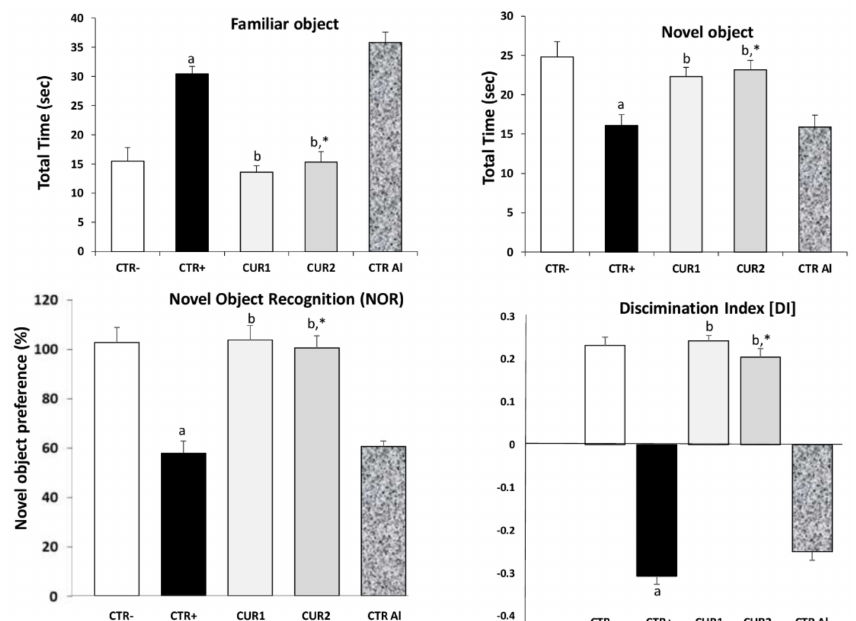
Figure 1. Effect of co and post-treatment of curcumin on cognitive impairment on rat model of Alzheimer’s Disease (AD) induced by chronic administration of AlCl 3 . Values are mean ± SEM. Note: CTR − : negative control group; CTR+: positive control group (treated by aluminum chloride (AlCl 3 )); CUR1: co-treatment with curcumin; CUR2: post-treatment with curcumin; CTRAl: exposed to AlCl 3 for 90 days and survive 60 days without any treatment; a: p < 0.05 as compared to CTR − group; b: p < 0.05 as compared to CTR+ group; *: p < 0.05 as compared to CTRAl group, repeated measures two-way ANOVA followed by Tukey’s test for multiple